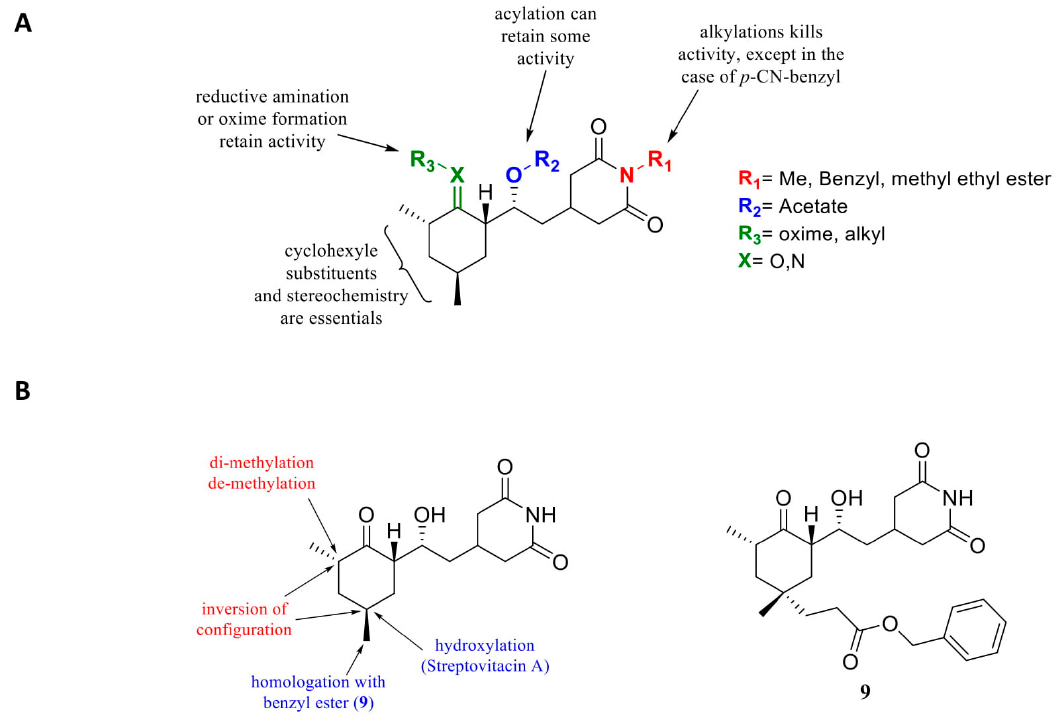
Figure 6. ( A ) Earlier structure activity relationship studies on cycloheximide. ( B ) Cycloheximide derivatives: in red, modifications leading to a loss of activity, in blue, conservation or slight enhancement of activity for compound 5 [132].